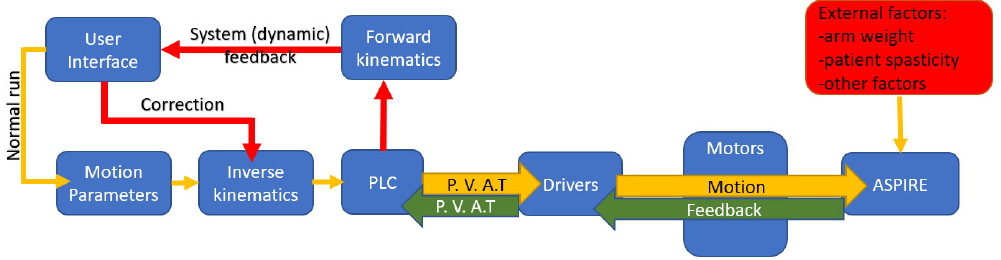
Figure 8. Dynamic control loop (P.V.A.T. = Positions, Velocities, Accelerations, Torque).